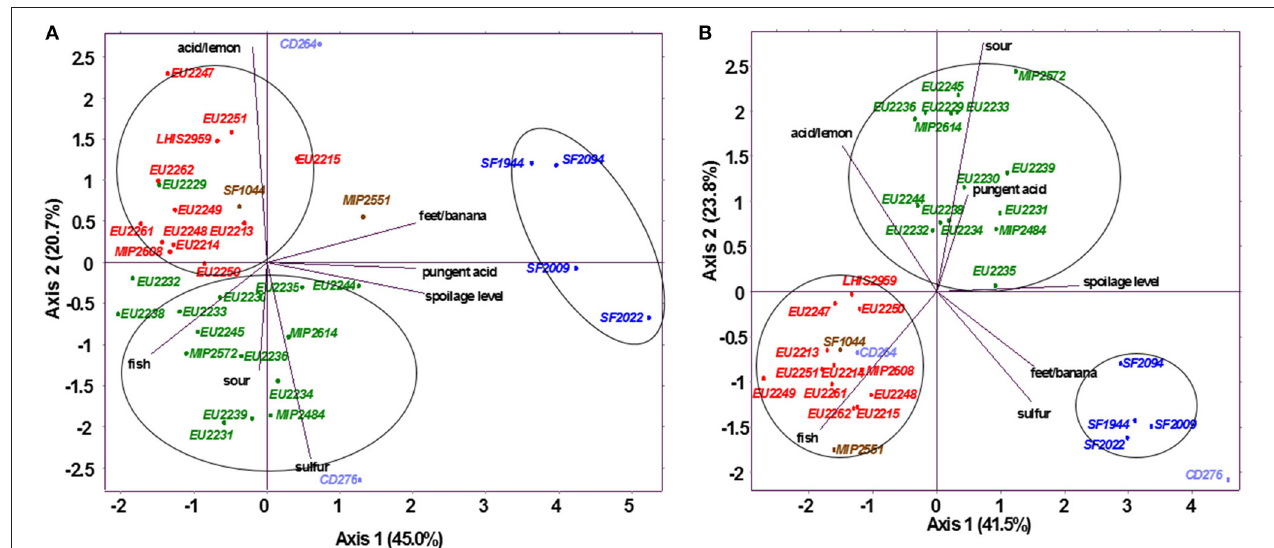
FIGURE 3 | Normalized principal component analysis representation of inoculated salmon juice (A) and cod juice (B) based on odor descriptors, on dimension 1–2. Strains in red: L . gelidum , in blue: C . maltaromaticum , in green: L . piscium , in brown: C . inhibens MIP2551 and A. viridans SF1044, in violet: V . fluvialis CD264 and V. penaei CD276.